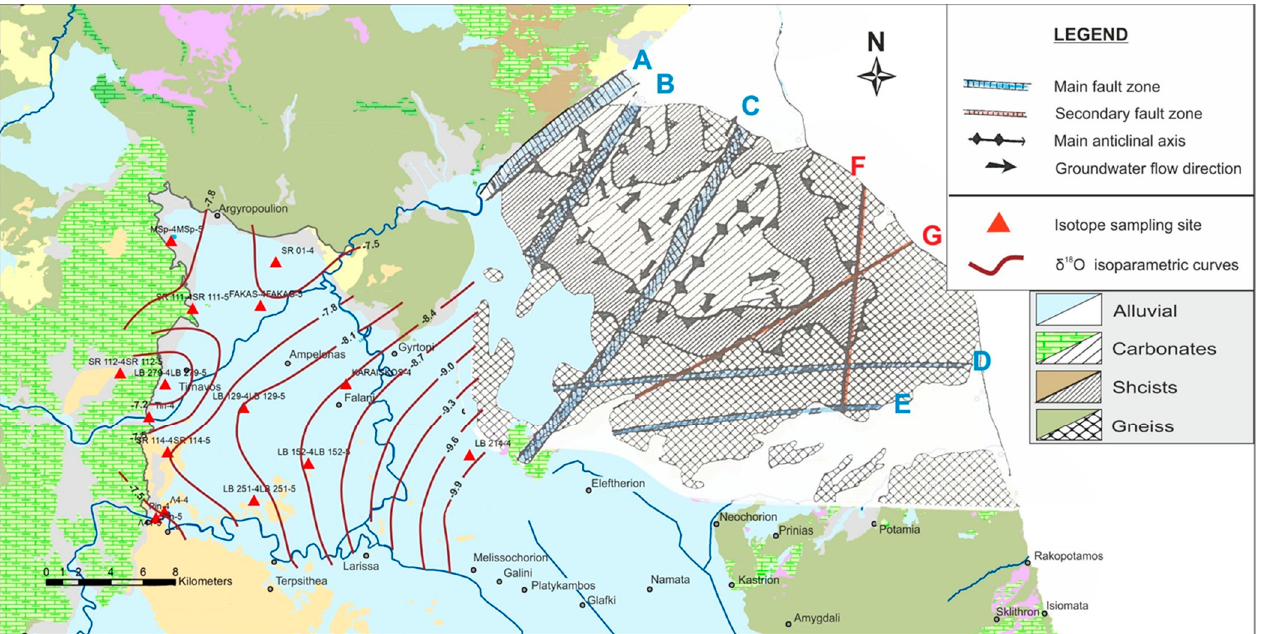
Figure 12. Spatial distribution of δ 18 O for groundwater (April 2018) and conceptualization of geological structure tectonic features and flow paths in the Ossa mountain, after [66].